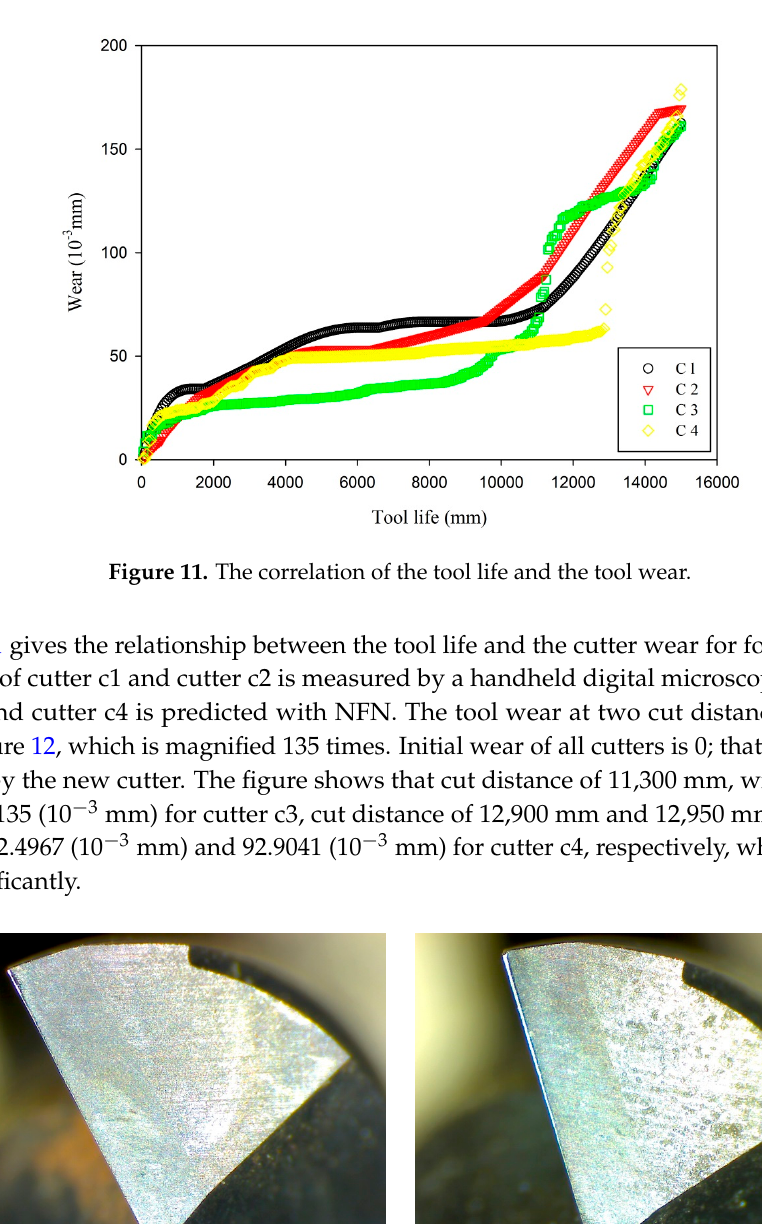
Figure 13. The user interface of tool wear and RUL.